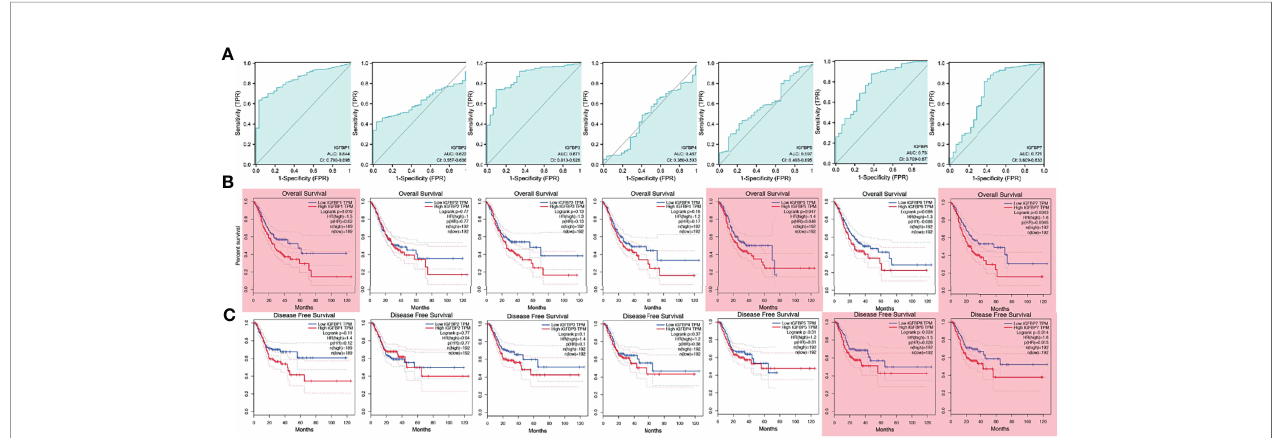
FIGURE 2 | Survival analysis and diagnostic value of IGFBP1 – 7 in STAD patients. (A) Diagnostic value of IGFBP1 – 7 in STAD patients. (B) Overall survival curve for IGFBP1 – 7 in STAD patients. (C) Disease-free survival curve for IGFBP1 – 7 in STAD patients. Results with p < 0.05 are marked with red